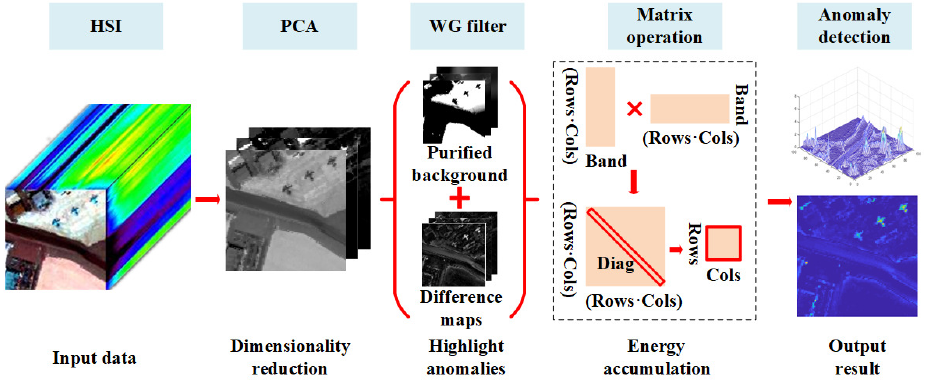
Figure 3. The workflow of the proposed anomaly detection